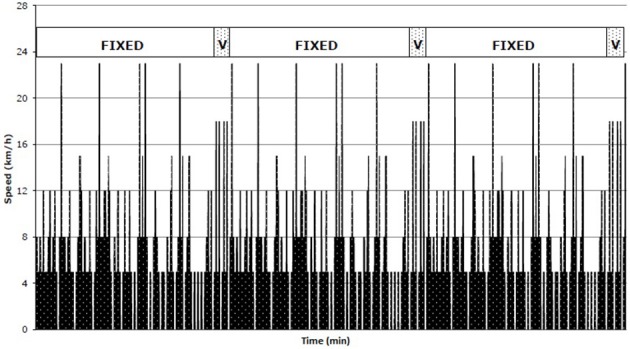
The 45-min activity profile of iSPT for a participant with a peak speed of 23 km·h−1 (obtained from Aldous et al., 2014).